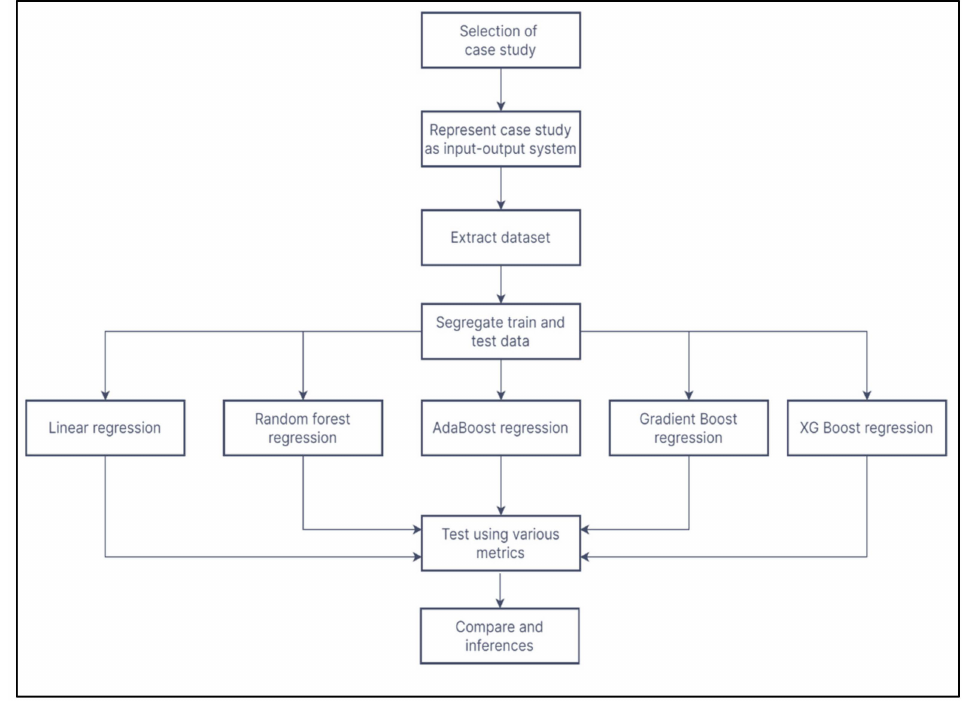
Figure 1. Flowchart of the